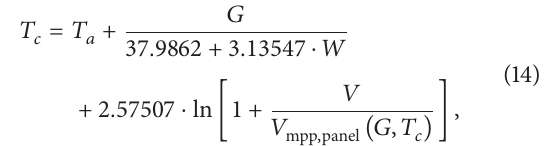
Figure 10: Kyocera panel operating temperature calculated with the novel correlation versus measured temperature.